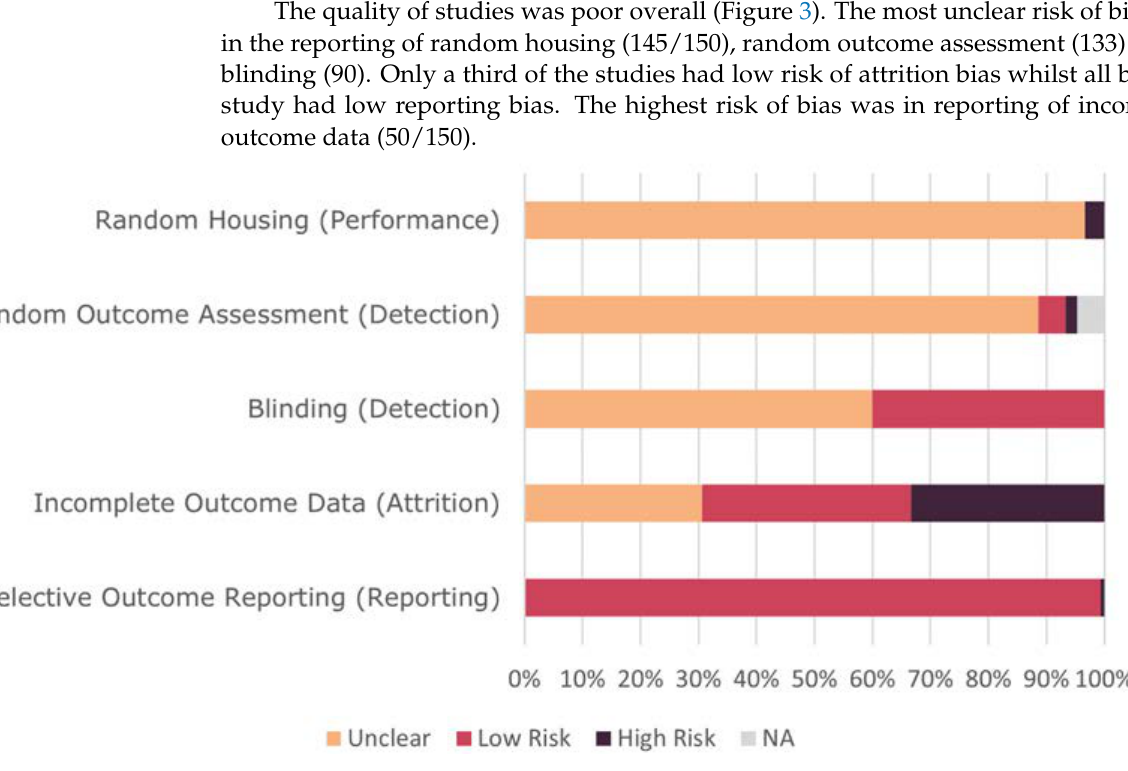
Figure 3. Risk of bias assessment summary. NA results of random outcome assessment refer to studies which tested mice simultaneously.